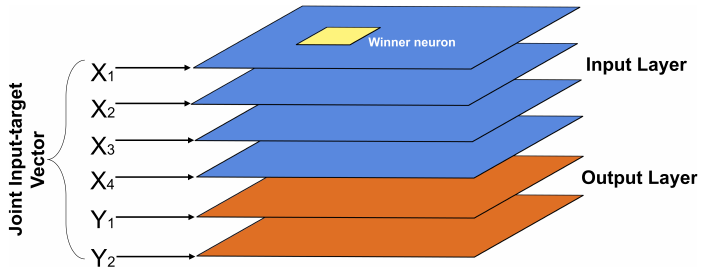
Figure 7. Supervised Kohonen network structure.